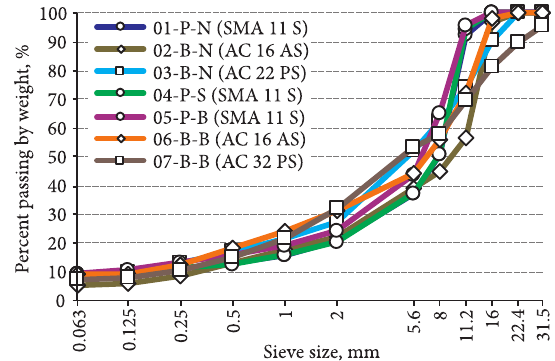
Fig. 1. Grading curve of tested